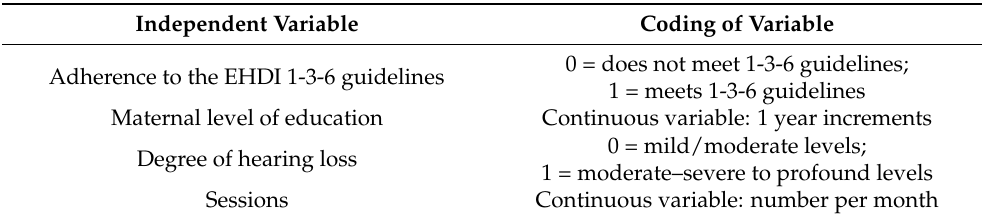
Table 3. Description of the Coding of the Independent Variables Included in the Structural Equation